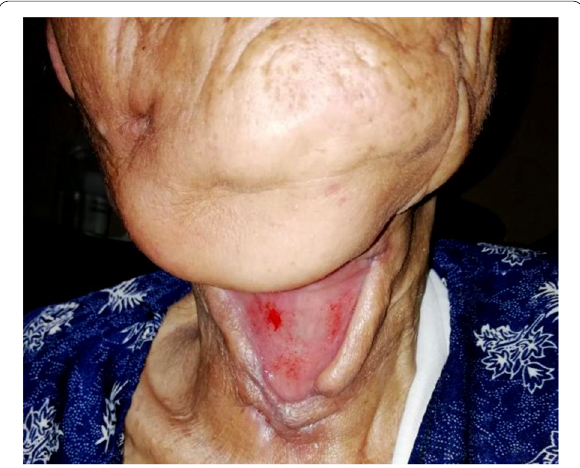
Fig. 2 Cervical skin loss after adequate incision, drainage, and debridement of Ludwig’s angina